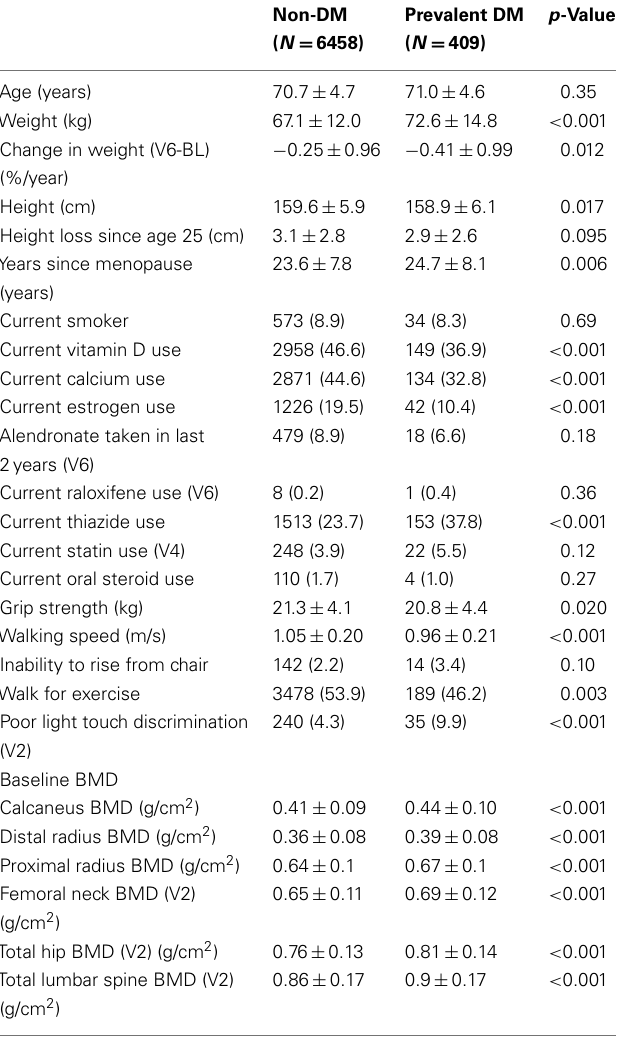
Table 1 | Characteristics a of women by diabetes status. incident DM separately. Results were similar with